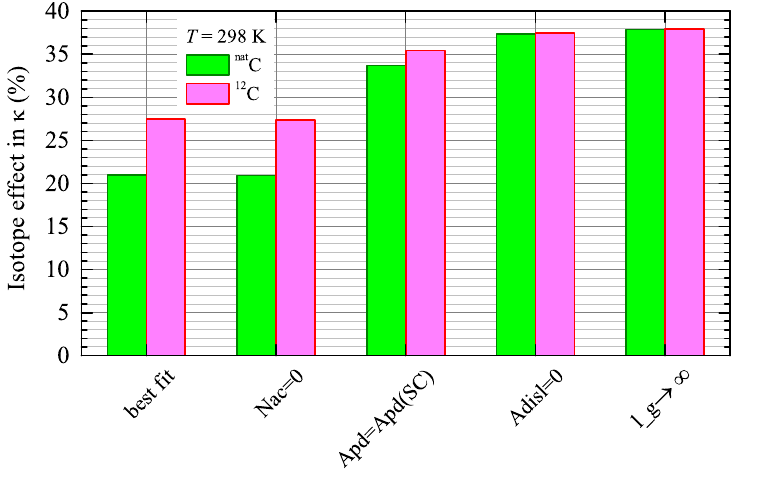
Figure 6. Calculated isotope effect in thermal conductivity of a diamond at 298 K for different sets of scattering processes. The scattering processes are eliminated/suppressed successively as indicated on the x -axis from left to right. The x -axis tick labels correspond to those for curves in Figure